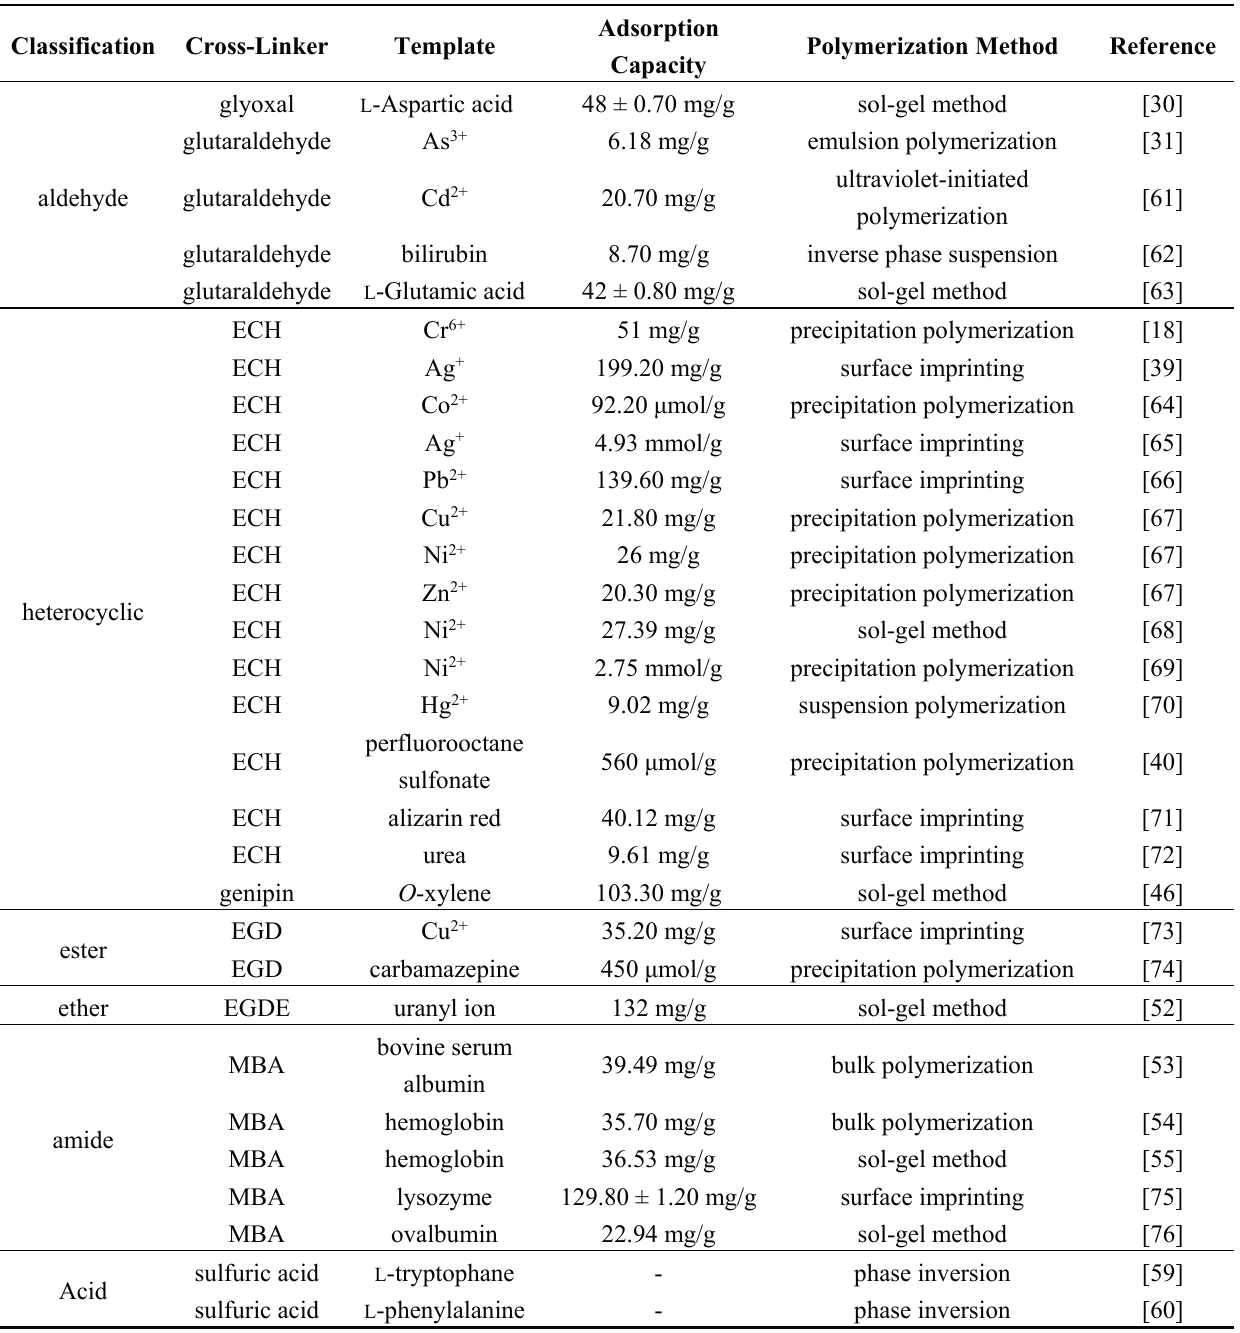
Table 1. Application of chitosan in